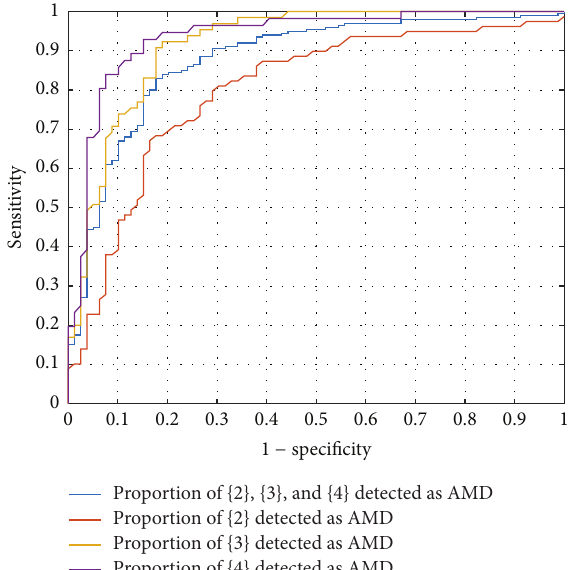
Figure 4: Screening performance for {1} versus {2 & 3 & 4} using SVM classifier and features selected using RF